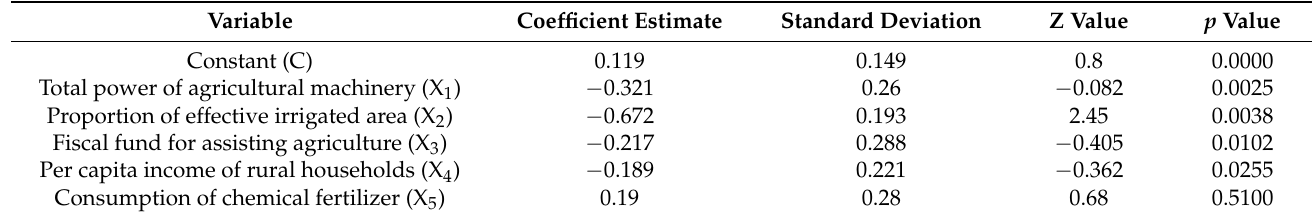
Table 3. Tobit regression analysis